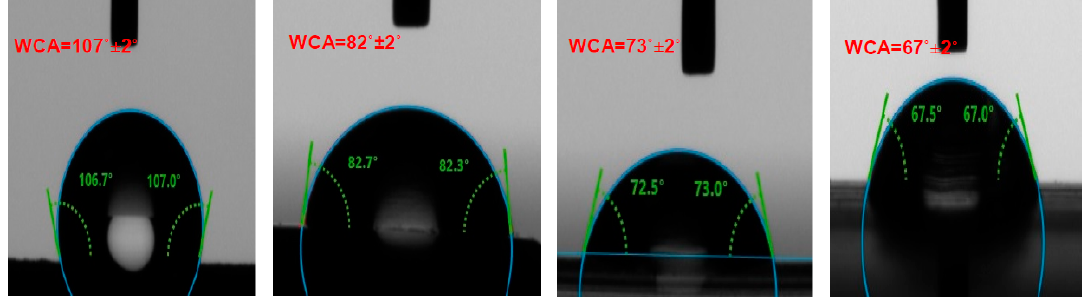
Figure 3. Contact angle of sessile water drop over different catheter surfaces.